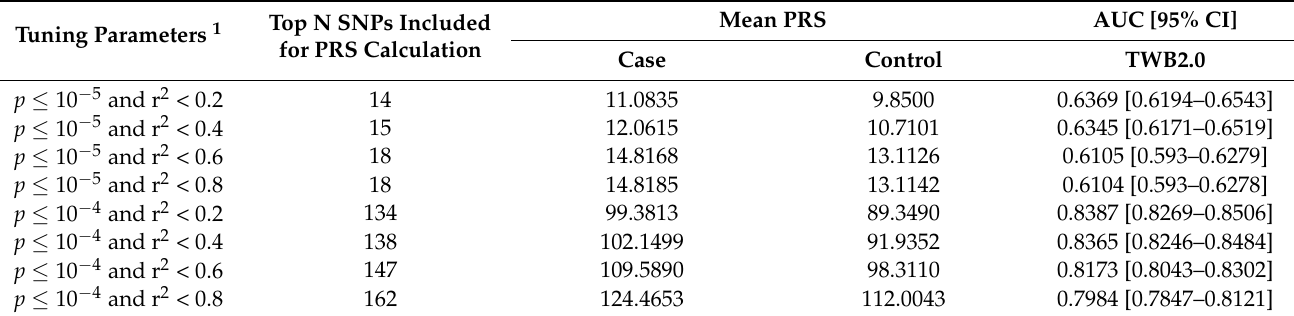
Table 3. Comparison of the predictive performance of Polygenic Risk Scores (PRS) with different tuning parameters, showing that the mean PRS are higher among cases than controls across all PRS models.